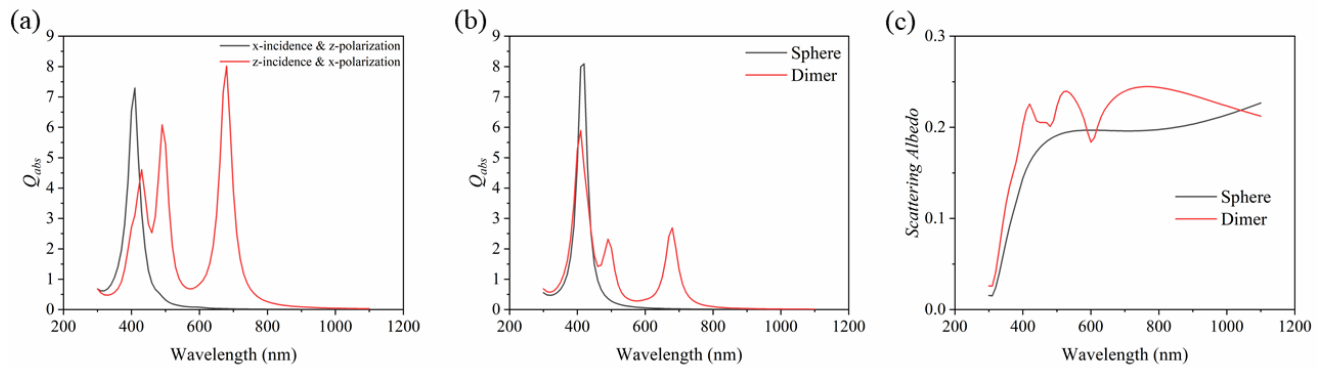
Figure 2. ( a ) Absorption efficiency of dimer in two directions, ( b , c ) comparison of absorption efficiency and scattering albedo between plasma dimer and ordinary single Ag sphere nanoparticle (curves are averaged over the three directions, and the three directions are x -incidence with z -polarization, z -incidence with x -polarization and x -incidence with y -polarization).